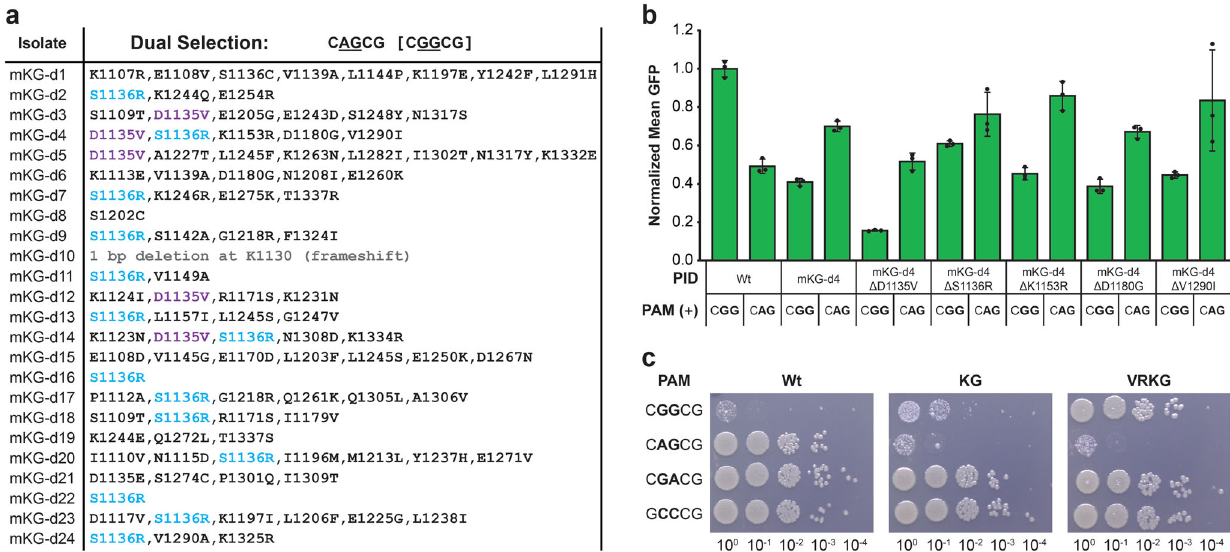
Fig. 3 Identi fi cation of D1135V/S1136R substitutions that augment NGG discrimination within the KG background. a List of non-synonymous PID substitutions identi fi ed in a dual-selection ω -dCas9 library experiment with random mutagenesis in the KG variant ’ s PID. The reporter plasmid ’ s PAM con fi guration is displayed above with the counterselection PAM in brackets. Cyan and violet lettering was used to emphasize the S1136R and D1135V substitutions, respectively, which were multiply represented. b GFP activation assays comparing Wt to the mKG-d4 isolate and its single-reversion ( Δ ) derivatives as indicated, with normalization as in Fig. 1b. The PAMs present in each single-target reporter plasmid is indicated below. Error bars, mean ± s.d. ( n = 3, biological replicates). c Plasmid cleavage assays comparing catalytically intact Wt, KG, and VRKG plasmids co-transformed with the single-target plasmids tested in Fig. 1c. 10-fold serial dilutions were plated in parallel on rich media with antibiotics to select for both plasmids and a minimally inducing concentration of IPTG (2.5 µ M) for Cas9 expression. Source data are available in the Source Data fi